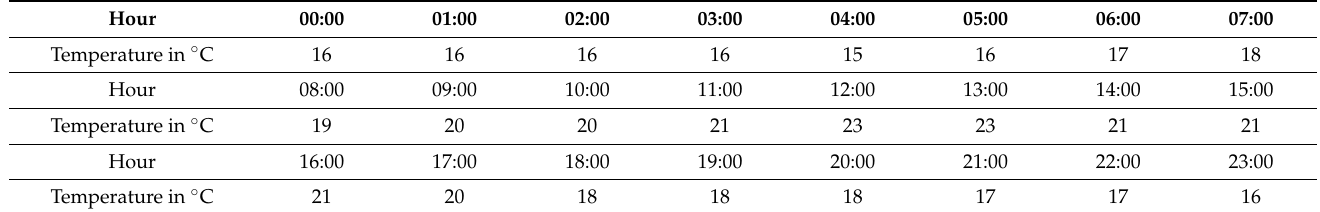
Table 9. Example of monitored hourly temperature